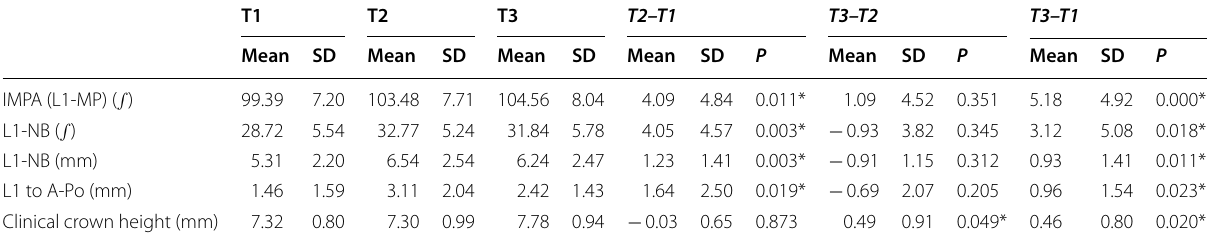
Table 2 Changes in mandibular incisor inclination and clinical crown height (gingival recession) in the three time point intervals (dependent t tests)